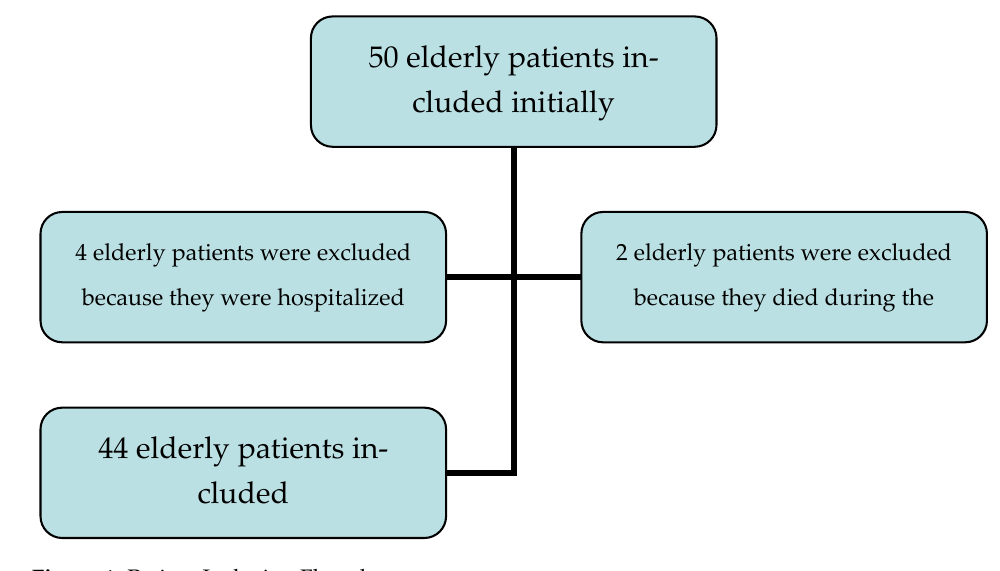
Figure 1. Patient Inclusion Flowchart. Table 1. Description of the sample population.